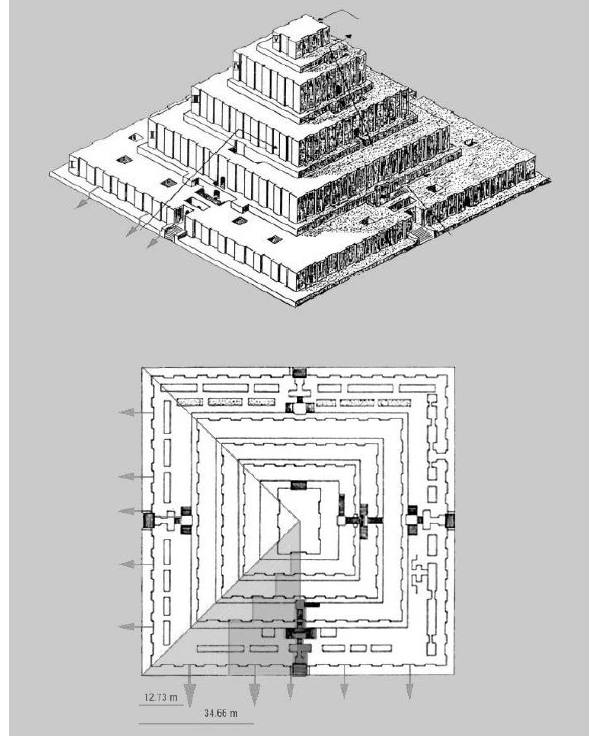
Figure 2. Drainage System in the Tchogha Zanbil ziggurat (Archive of Tchogha Zanbil